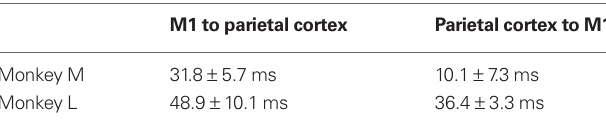
Table 2 | Phase delays for directed coherence between M1 and parietal